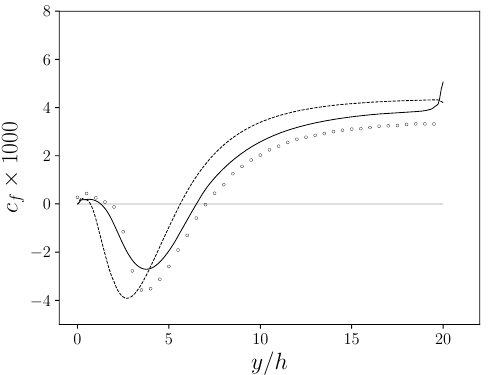
Figure 11. Skin friction coefficient c f along the heated wall. : Simulation results with the anisotropic four-parameter (A4P) model; : Simulation results with the isotropic four-parameter (4P) model. DNS